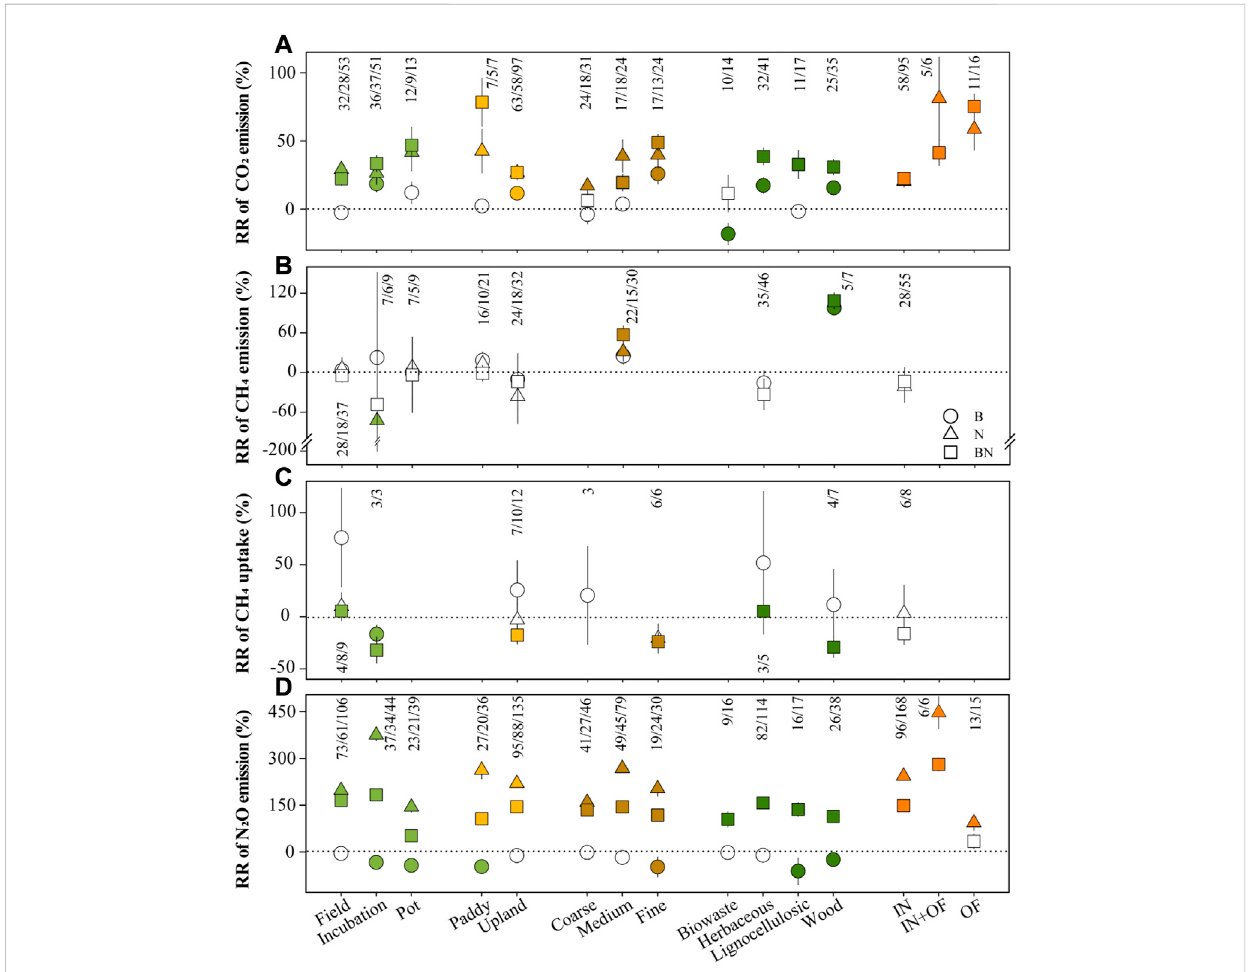
FIGURE 3 The responses of soil CO 2 emission (A) , CH 4 emission (B) , CH 4 uptake (C) and N 2 O emission (D) to predictors under BN